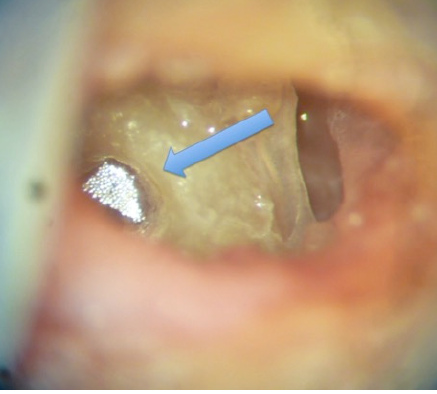
Figure 1. Reflector on the round window (white color). The blue arrow shows the round window. The pinna and the soft tissue behind it were removed on each side to adequately expose the mastoid bone and the space needed for the implants. BAHA™ implants (Cochlear™, Sydney, NSW, Australia) were placed at three different locations bilaterally. They were all set at the same distance (2.5 cm) from the external auditory canal at 0 ◦ , 45 ◦ , and 90 ◦ from the Frankfort plane (Figure 2), a virtual line passing through the external auditory canal and extending to the inferior limit of the orbital rim.